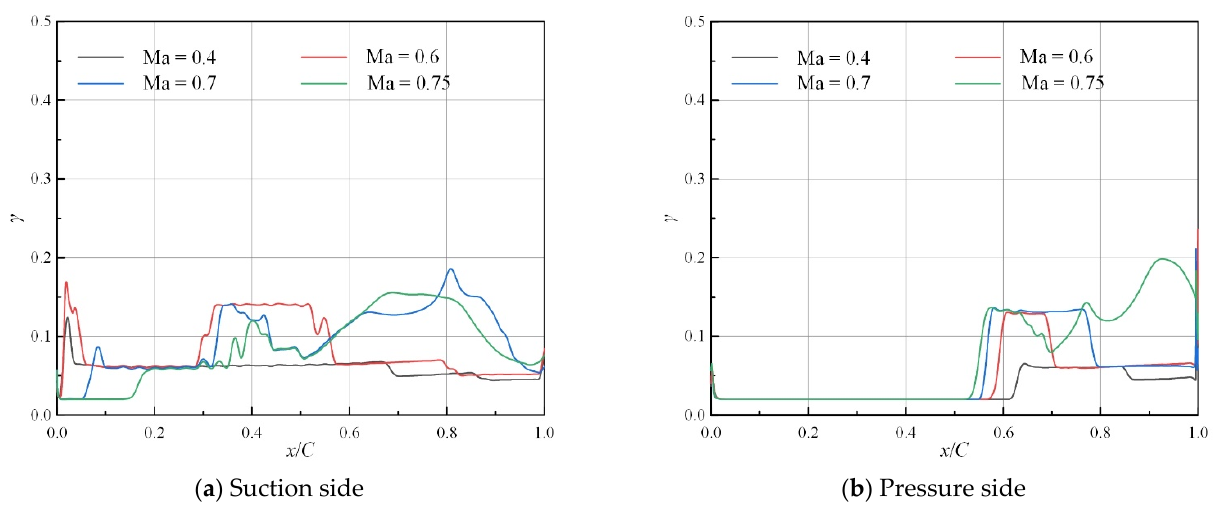
Figure 20. Distribution of intermittency along streamwise direction under various Mach numbers ( ε = 0.5%, α = − 3°, T w = 293 K).